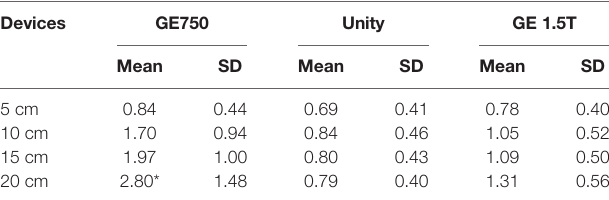
TABLE 1 | Maximum distortion values and the standard deviation of the three devices in the different radius ranges,